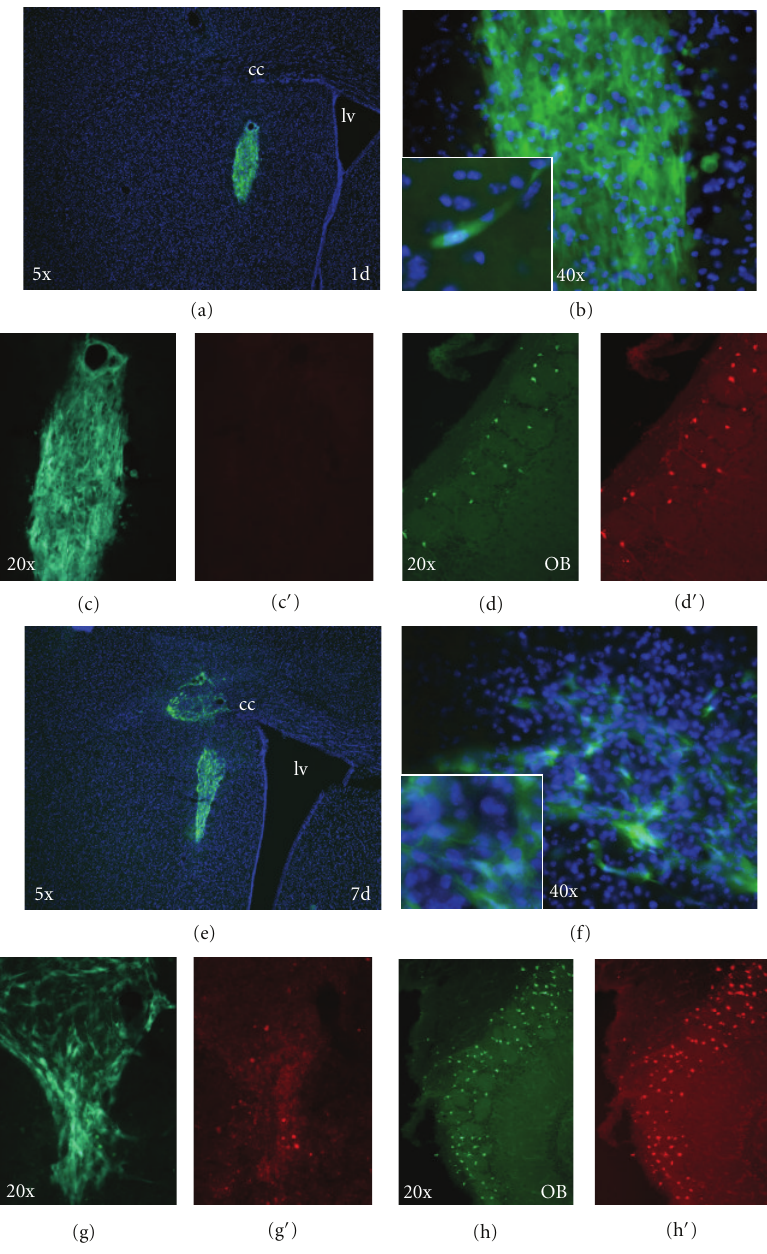
Figure 6: Detection of MSC-EGFPs after intrastriatal delivery. (a) 1d after implantation, endogenous eGFP fluorescence from MSCs is found proximal to the injector needle track. Tissue counterstained with DAPI. (b) At higher magnification (40x), fibroblast-like structure of implanted MSC-EGFPs can be seen. Fluorescence is detected on GFP (c), but not Texas Red (c (cid:3) ) emission filters. In the OB, autofluorescence is detected on both the GFP (d) and Texas Red (d (cid:3) ) emission filters. (e) 7d after implantation, endogenous eGFP fluorescence from MSCs is found around the injector needle track. Tissue counterstained with DAPI. (f) At higher magnification (40x), implanted MSC-EGFPs can be seen. Fluorescence is detected on GFP (g), and Texas Red (g (cid:3) ) emission filters, although there is no overlap with GFP signal. In the OB, autofluorescence is detected on both the GFP (h) and Texas Red (h (cid:3) ) emission filters. Abbreviations: cc: corpus callosum; lv: lateral